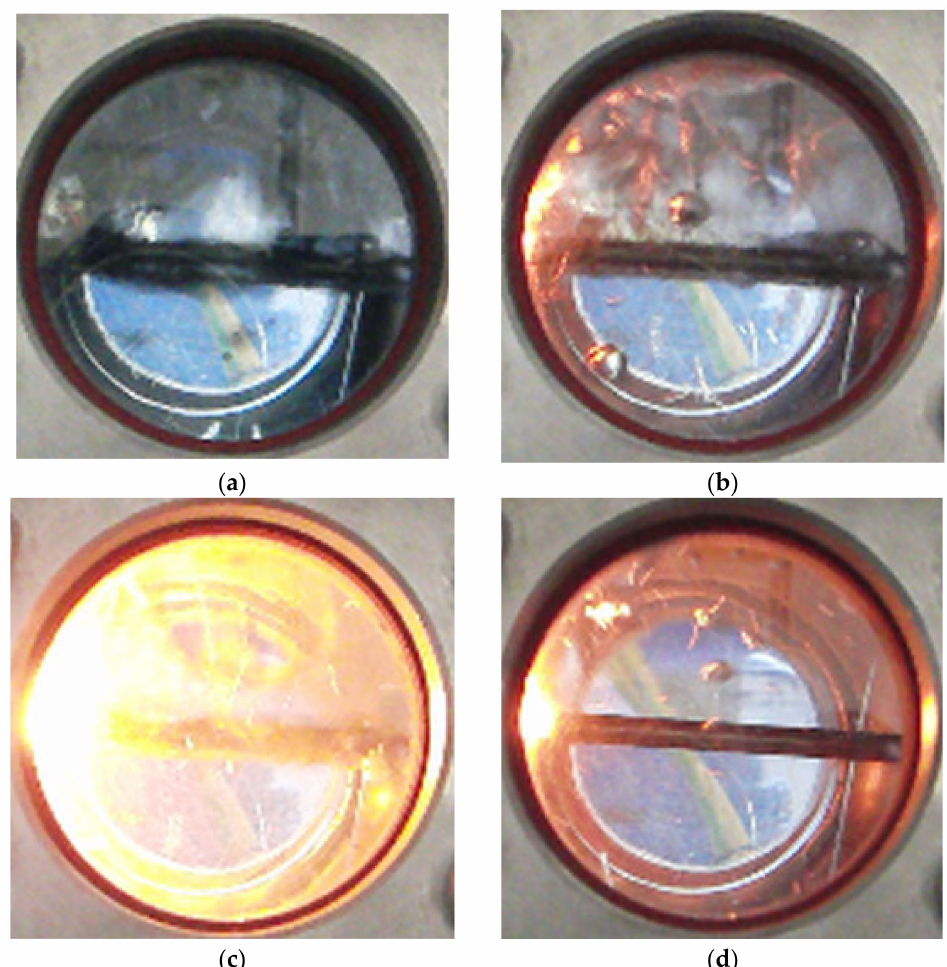
Figure 3. Burnout process: ( a ) developed NPB, ( b ) burnout incipience (left side of picture), ( c ) burnout, ( d ) end of